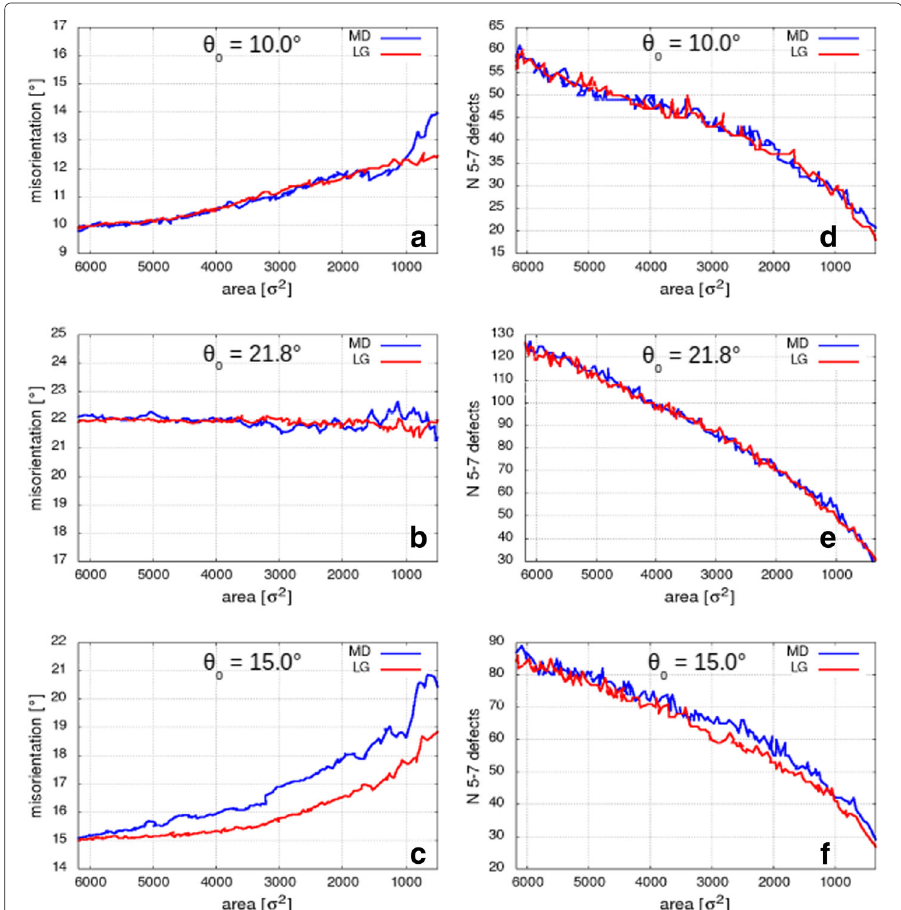
Fig. 2 a - c Evolution of the misorientation angle θ and ( d - f ) of the number of 5-7 defects along the grain boundary as a function of the grain area, for the initial values θ 0 = 10 ◦ ,21.8 ◦ ,15 ◦ . The results obtained with the LD model (red) are compared with the ones obtained with MD simulations